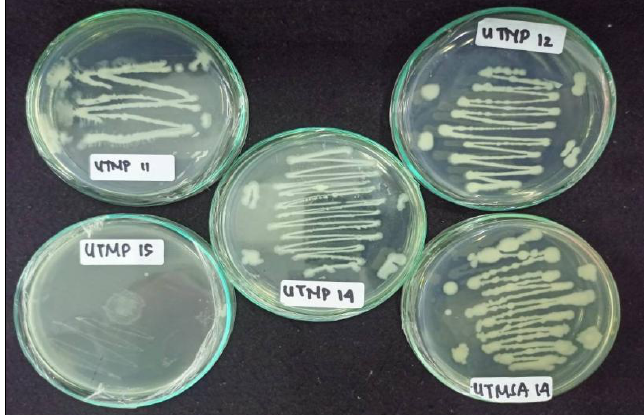
Figure 3: Culture results for macroscopic observations of Bacillus subtilis UTMP11, Bacillus subtilis UTMP12, Bacillus tequilensis UTMP14, Bacillus tequilensis UTMSA14, and Bacillus subtilis UTMP15 culture in NA (Nutrient Agar) media. Table 1: Biochemical characterization of Bacillus subtilis UTMP11, Bacillus subtilis UTMP12, Bacillus tequilensis UTMP14, Bacillus tequilensis UTMSA14, and Bacillus subtilis UTMP15. Isolates code